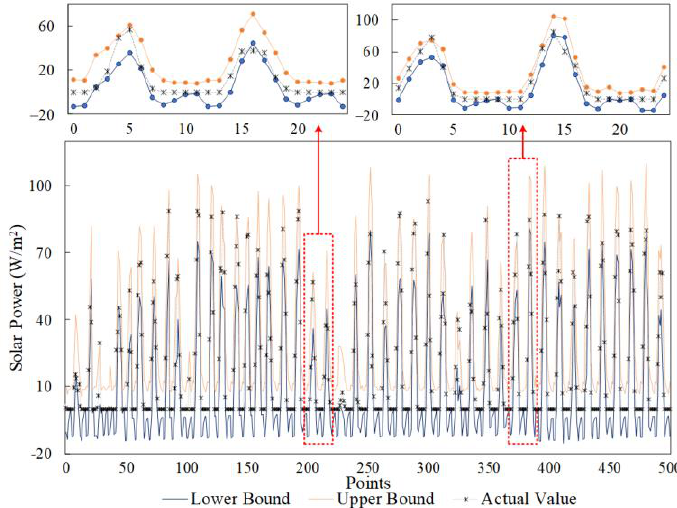
Figure 8. The prediction results obtained by PSO and WI w/o ELM-AE.